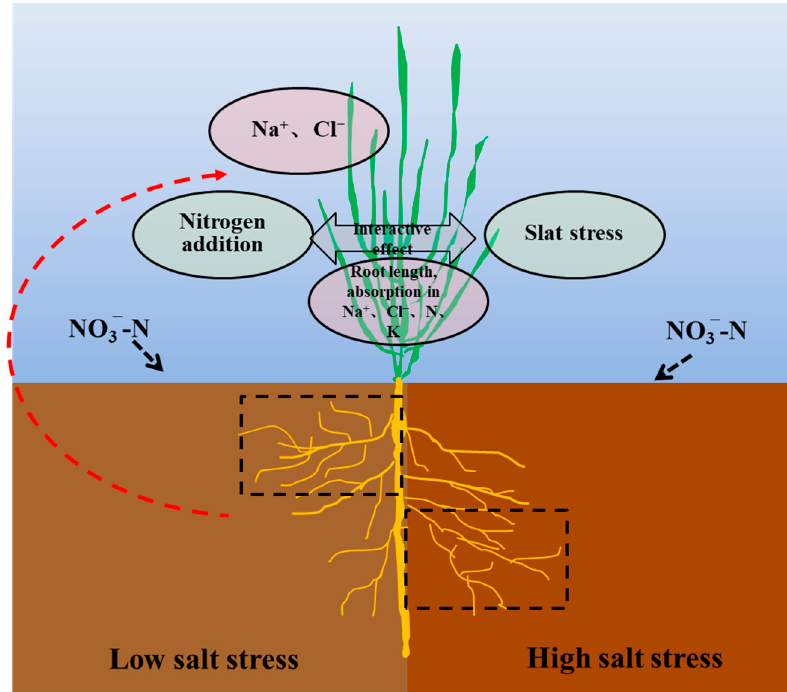
Figure 6. Diagram of the interactive effect between salt and NO 3 (cid:2879) ‐ N on root growth and ion accu ‐ mulation of Suaeda salsa . Dotted boxes represent the positive effect on root elongation in the different soil layer.